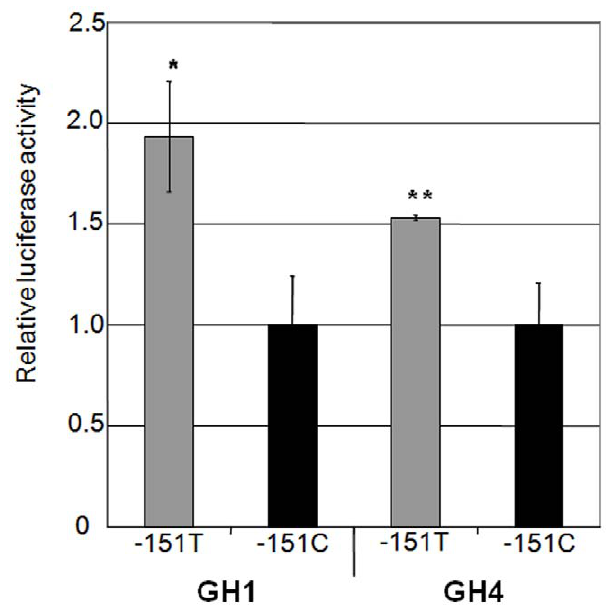
Figure 3. Transcriptional activity of the 2 151 wild type (C) and the variant (T) GHSR promoter. Activity of GHSR –151T versus 2 151C 2 643/pGL3 GHSR gene constructs in GH1 and GH4 cells. Values represent the mean 6 SD of at least 3 measurements of luciferase activity normalised with CMV-renilla activity expressed as fold induction relative to the activity of the wild type promoter. P values: * p =0.0005 and ** p =0.02, calculated by t-test for independent samples.